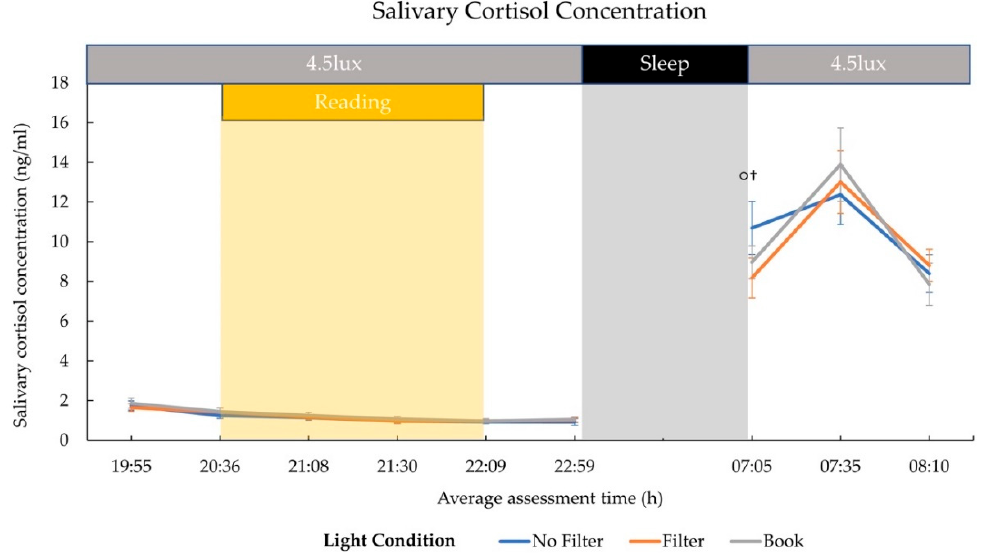
Figure 2. Time course of salivary cortisol concentration (mean and standard error). The 4.5 lux label corresponds to the background room lighting and refers to photopic lux. During the 8 h sleep interval, lights were switched off (0 lux). Cortisol concentration at awakening was by trend higher in the “No Filter” than in the “Filter” condition. Another statistical trend was present for a higher cortisol increase in the “Filter” compared to the “No Filter” condition within 30 min after awakening (cf., Supplementary Figure S1). ◦ = p ≤ 0.10; † = p adj . > 0.10.